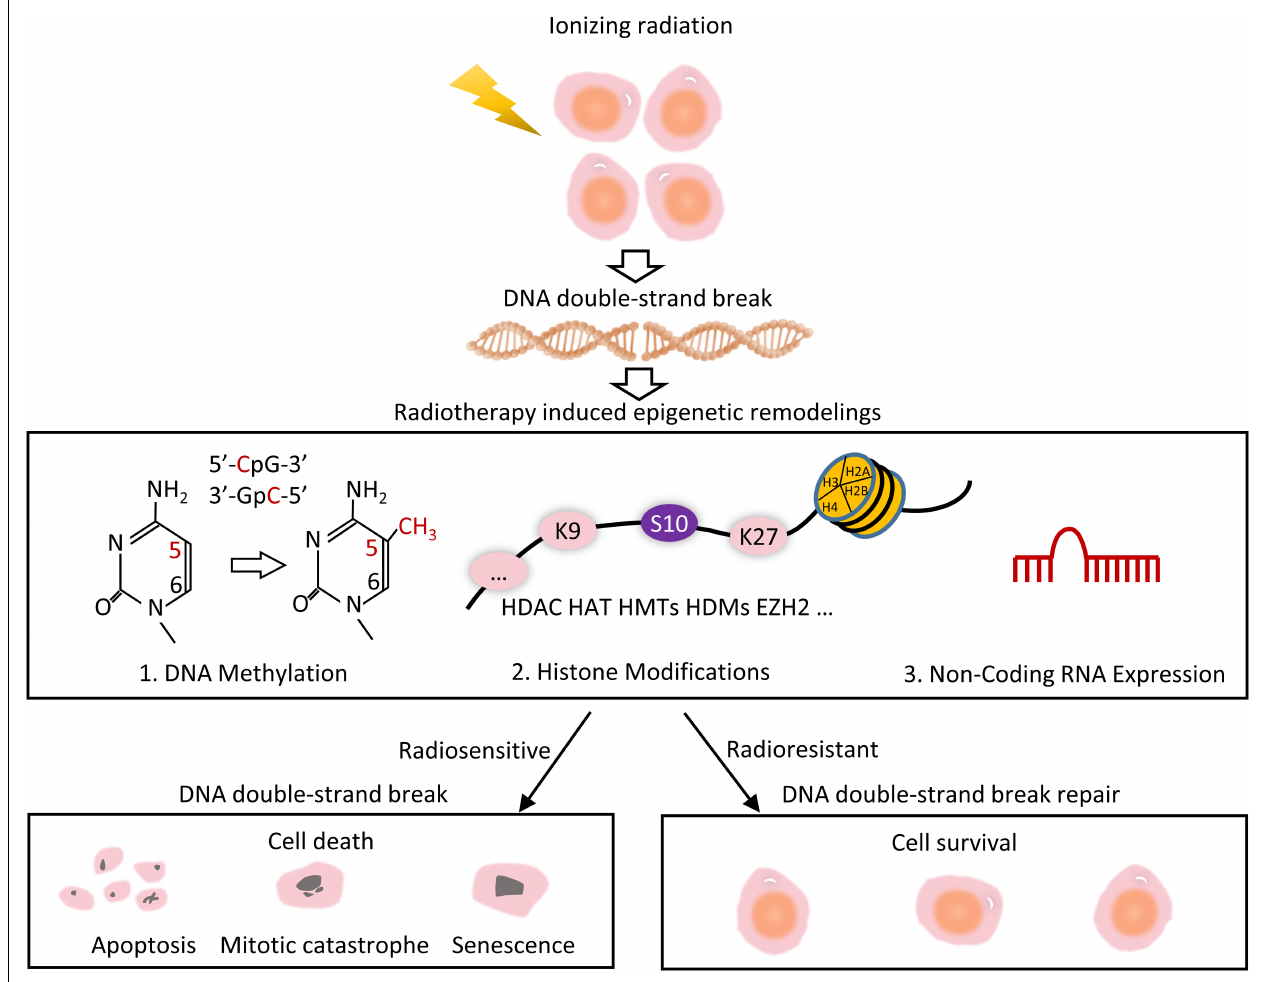
FIGURE 1 | Overview of radiotherapy induced epigenetic remodeling. Radiotherapy uses ionizing radiation to generate DNA strand breaks. Mis-repair of DNA results in a variety of epigenetic changes, include radiation-induced DNA methylation, histone modifications, and modulation of non-coding RNA expression. Some cells are resistant to DSB repair, leading to radioresistant and cell survival, whereas the others are radiosensitive, eventually leading to cell death.